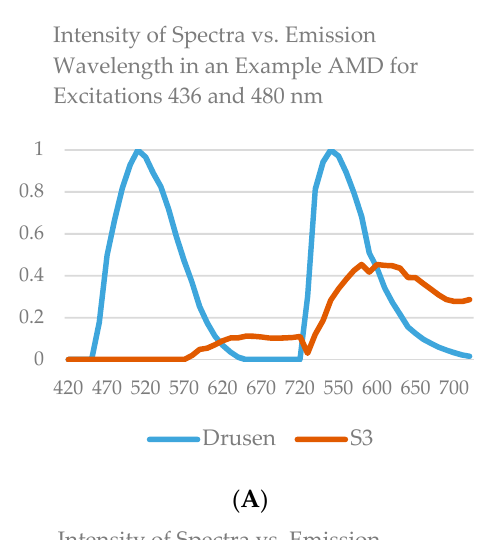
of RPE fluorophores obtained by going from two excitations (left) to three (right), is evident, and